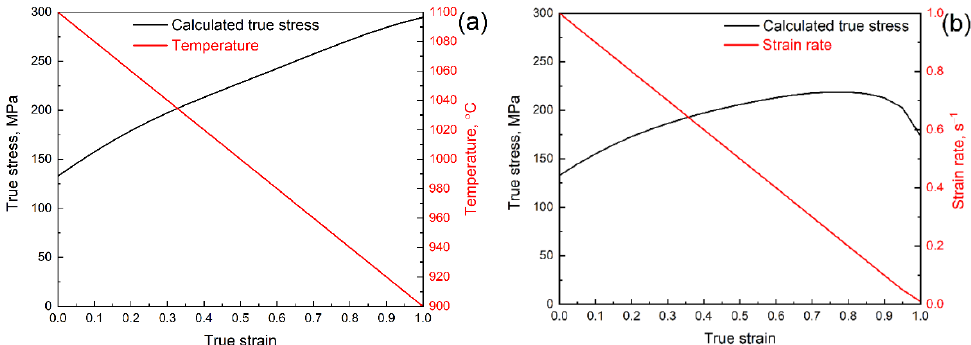
Figure 7. The calculated true stress values in the case of the changing of the temperature at a constant strain rate of 1 s − 1 ( a ) and in the case of the changing of the strain rate at the same temperature profile ( b ).